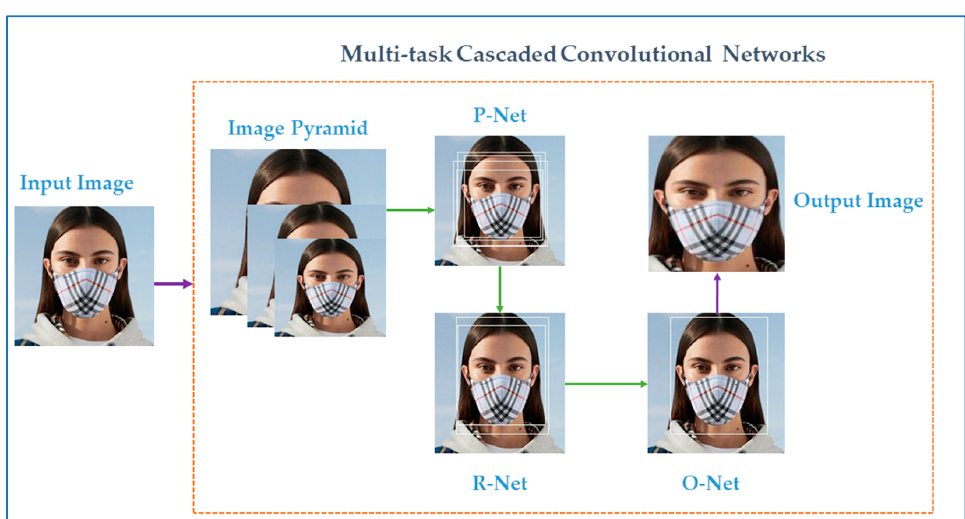
Figure 5. The entire face detection process over raw face images using MTCNN.